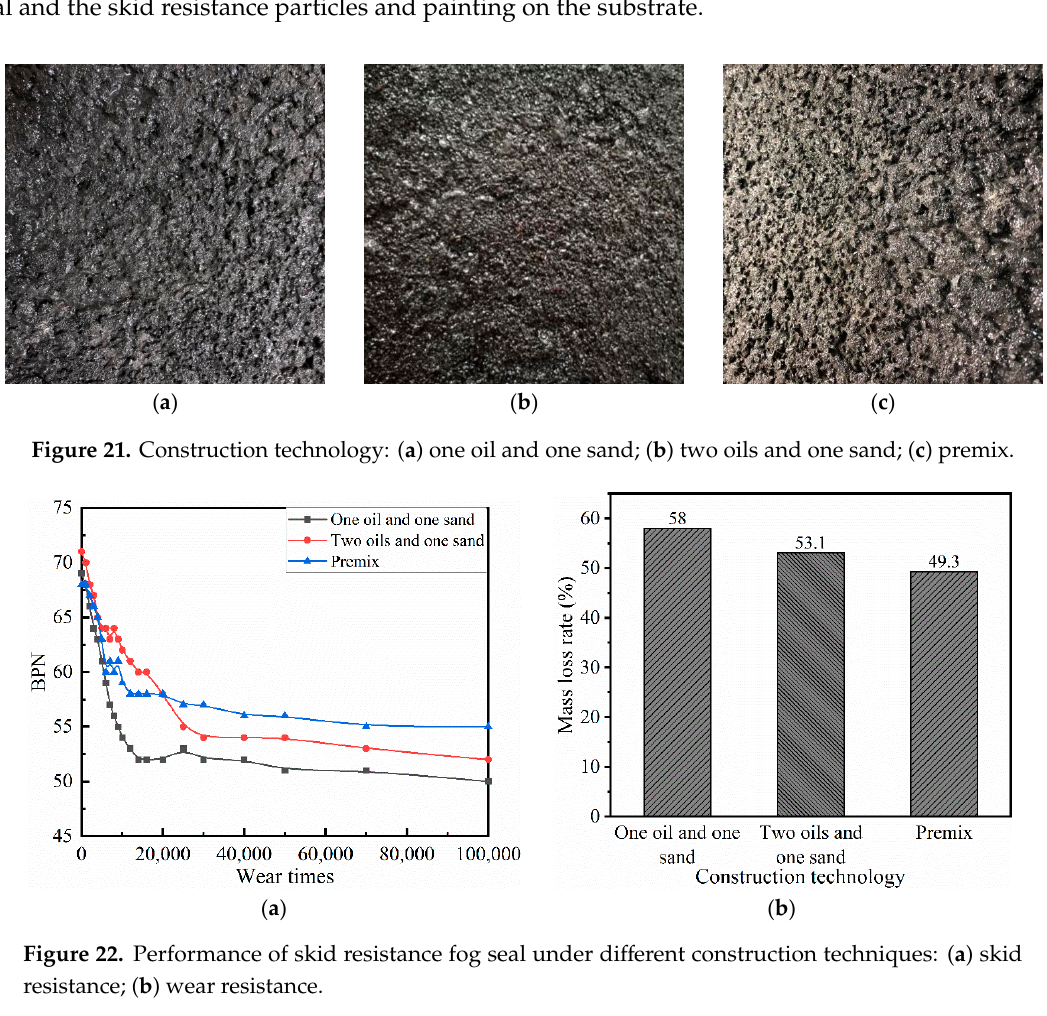
Figure 20. Contact angle measurement image: ( a ) BE-4 modified emulsified asphalt; ( b ) HPFA.